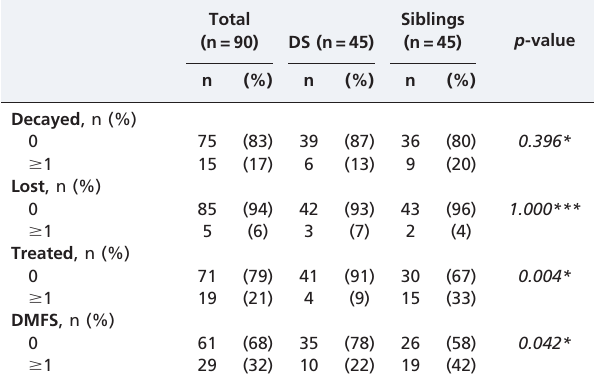
Table 2 - Organized data for DMFS index